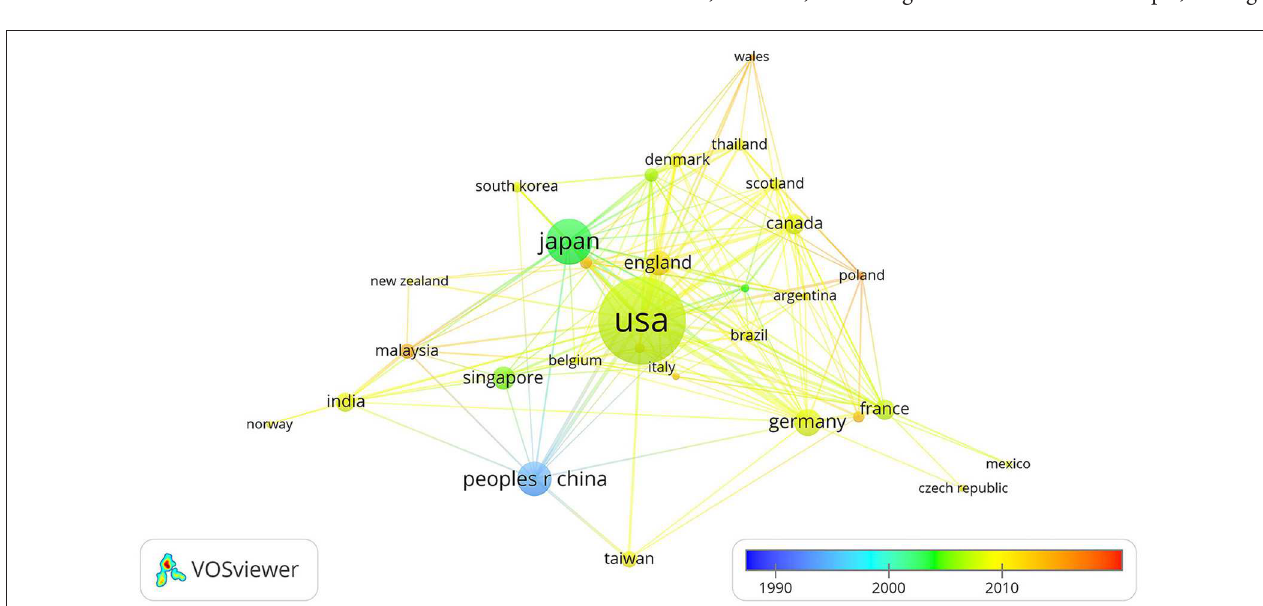
FIGURE 2 | Network showing cooperation among countries. Large dots indicate countries with high numbers of publications. The color of each dot represents when the publication is released. Thick lines between dots indicate cooperation among numerous countries.